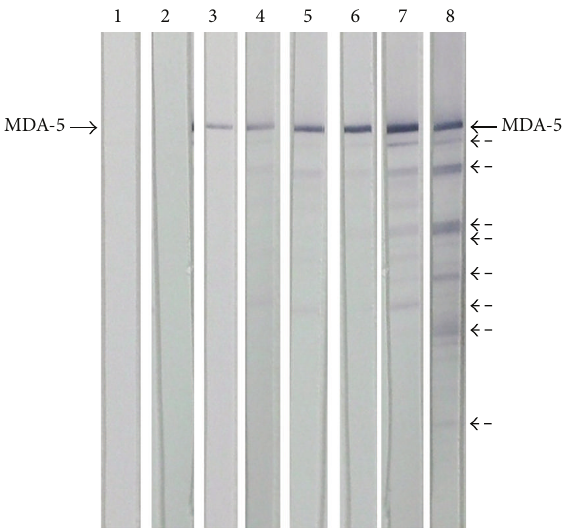
Figure 1: Immunoblots showing the reactivity of IgG antibodies from dermatomyositis patients against commercially available purified recombinant MDA5. Lanes 3 and 4 (+), 5 and 6 (++), and 7 and 8 (+++) were considered positive results. Lanes 1 and 2 corresponded to negative serum samples. Dashed arrows are probably degradation products of